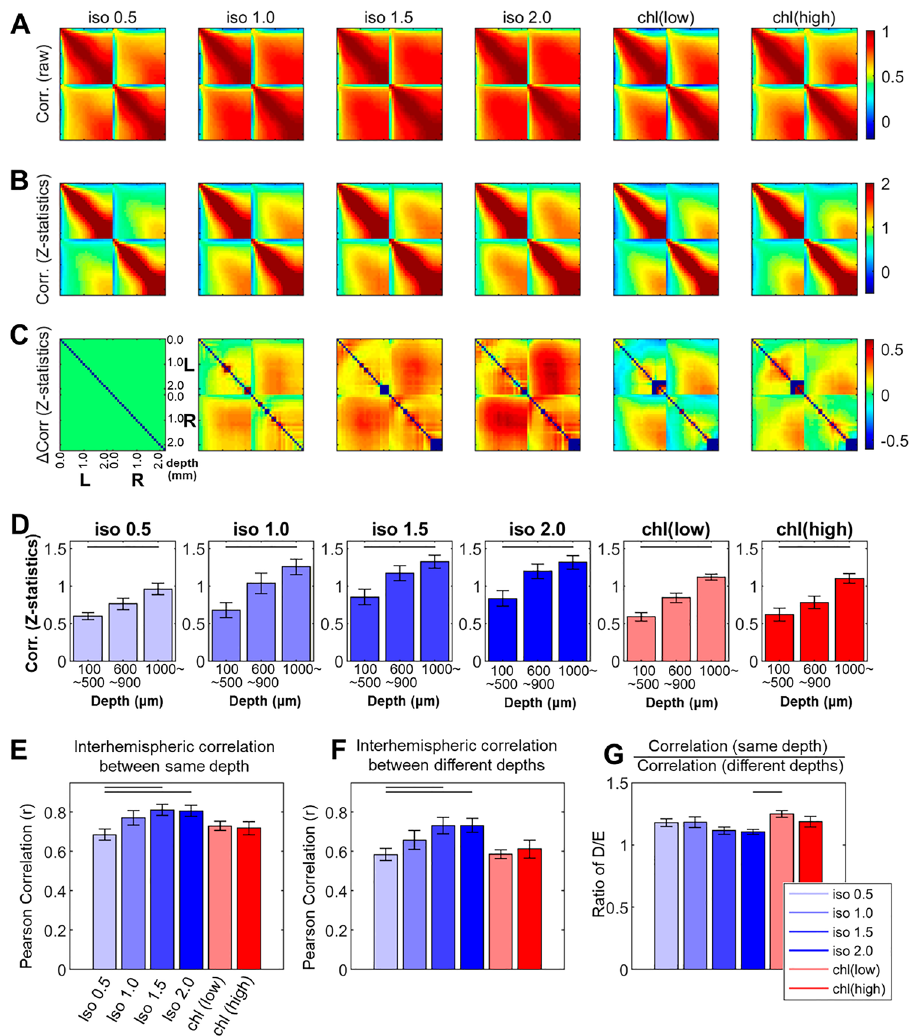
Figure 3. Laminar correlation in spontaneous LFP activity along cortical depth (0.0 ~ 2.2 mm) across different anesthesia conditions (Group mean, n = 8). ( A ) Pearson’s correlation coefficient r across spontaneous LFP activity in bilateral S1fl. ( B ) Z-statistics calculated by Fisher transformation. ( C ) Difference in z-statistics between isoflurane 0.5% and other anesthesia conditions. High dose of isoflurane increased the diffused correlation centered around middle layers, but α-choloralose (low dose, in particular) strengthened interhemispheric correlation in a layer-specific pattern. ( D ) Inter-hemispheric correlation (z-statistics) at the supragranular, the granular and the infragranular layers. ( E ) Average inter-hemispheric correlation between left and right S1fl at same depth. ( F ) Average inter-hemispheric correlation between left and right S1fl at different depths. ( G ) Layer-specificity in the interhemispheric correlation estimated by ratio of E (same depth) and F (different depths). Horizontal bar: p < 0.05 in post-hoc Tukey’s